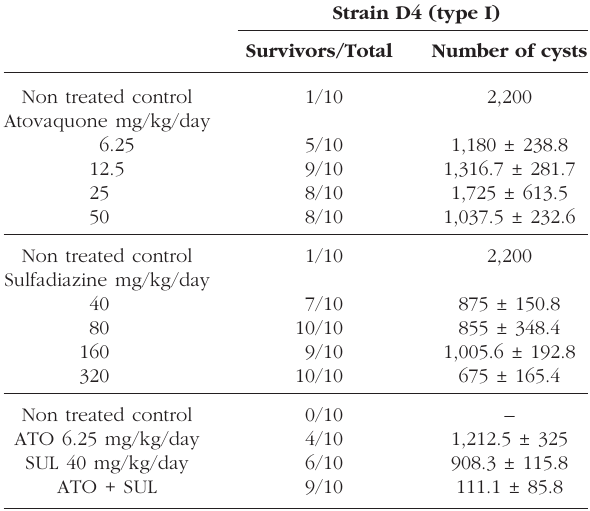
Table III. – Survival and number of brain cysts in mice infected with D4 strain of T. gondii and treated with different doses of atovaquone (ATO), sulfadiazine (SUL) or drug association (ATO + SUL).